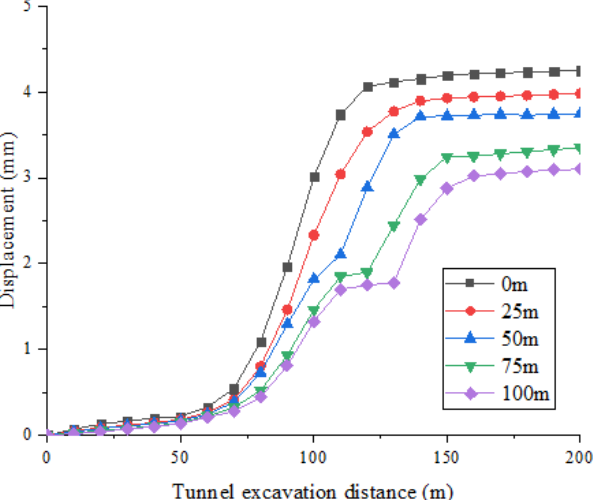
Figure 8. Variation curve of displacement of monitoring point 1 with tunnel excavation surface spacing.